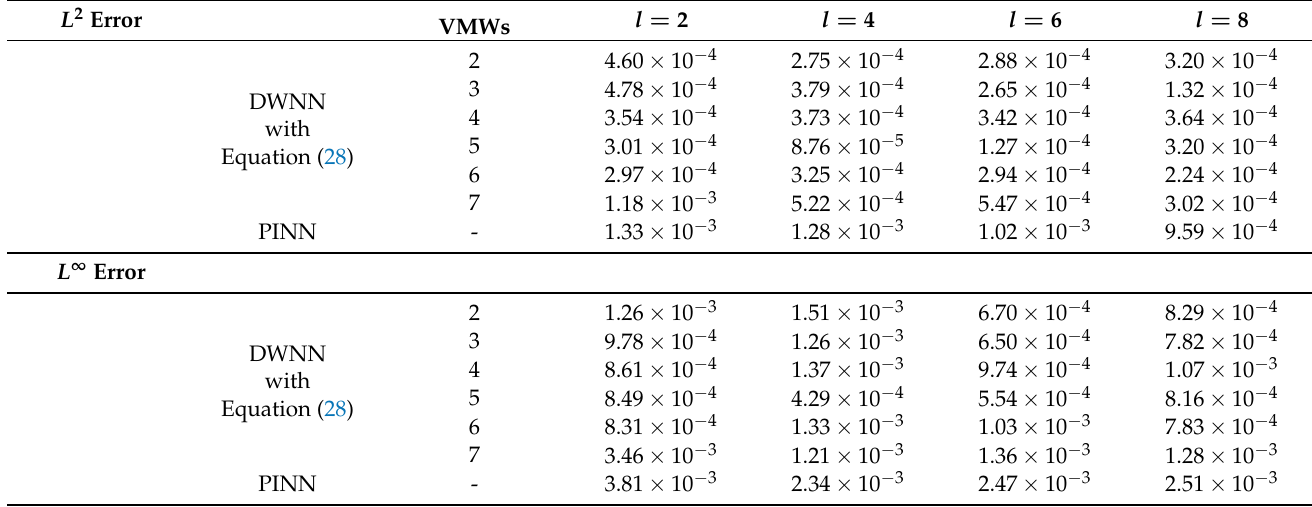
Table 3. The L 2 errors and L ∞ errors for 1D carburizing diffusion